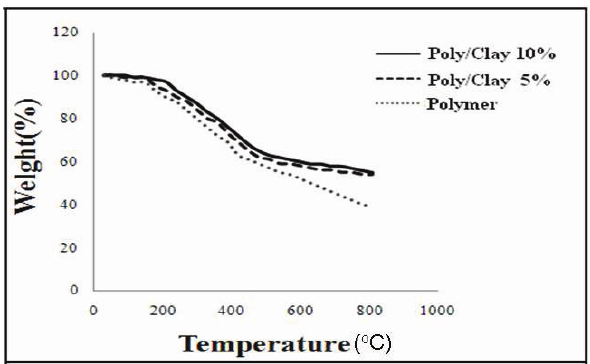
r Figure 5. TGA thermograms of neat PA 3 and PA- nanocomposite films 3a & 3b